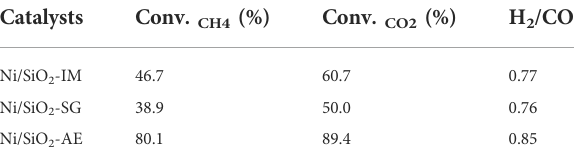
TABLE 3 Catalytic performance of Ni-based catalysts. Catalysts